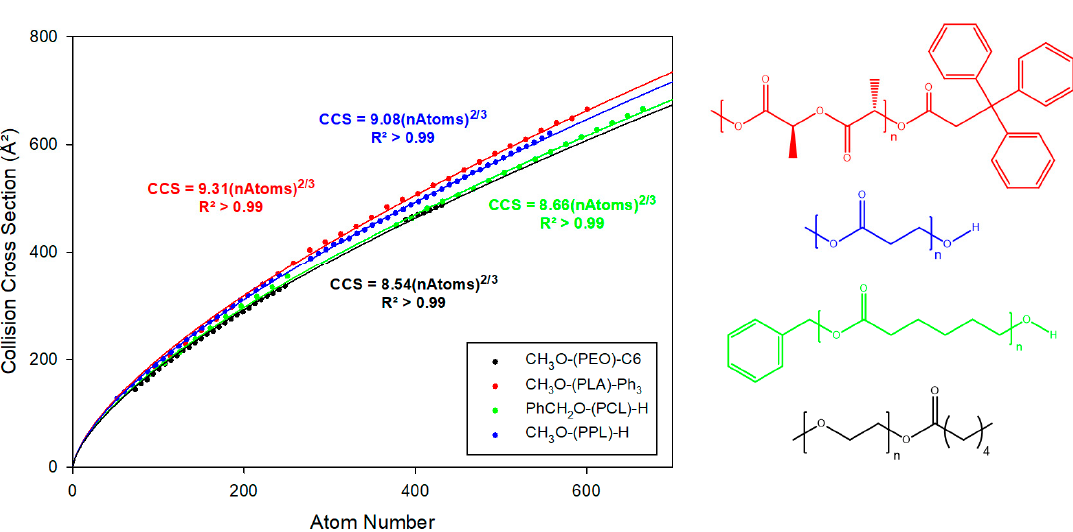
Figure 5. Evolution of the collision cross-section as a function of the number of atoms for singly and doubly charged globular ions produced from α -methyl ω -C6-PEO (Black), α -methyl ω -Ph 3 -PLA (Red), α -methyl ω -hydroxy-PPL (Blue), and α -benzyl ω -hydroxy-PCL (Green). Fittings are performed using the equation CCS = A (cid:48) nAtoms 2 3 ; the equations and regression coe ffi cients of each fit are also reported.